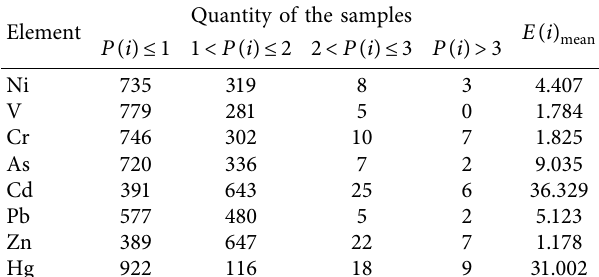
Table 4: Soil element risk assessment table. Quantity of the Element